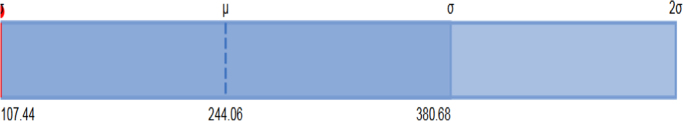
α-diversity of the data set. The min, max, and mean values along with the standard deviation ranges (σ and 2σ) in varying shades are shown. The α-diversity of this metagenome dataset is shown in red. Alpha diversity sum up the diversity of organisms in a particular sample by a single number.